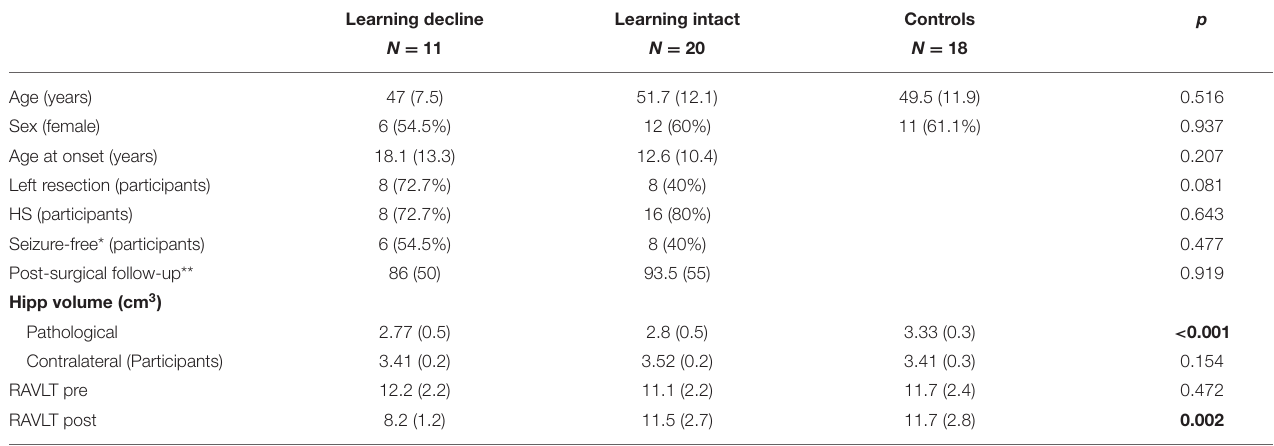
TABLE 1 | Sociodemographic and clinical characteristics of Temporal Lobe Epilepsy patients and controls. Learning